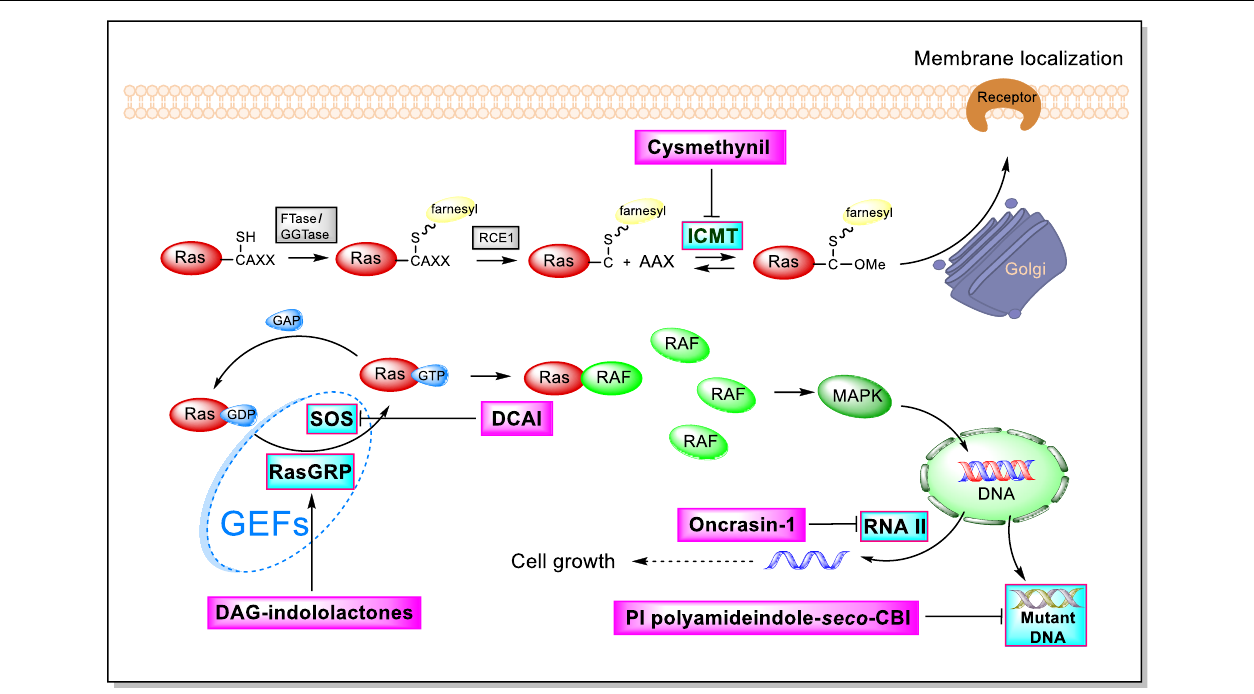
FIGURE 3 | Influence of indole derivatives on the Ras-Related signaling